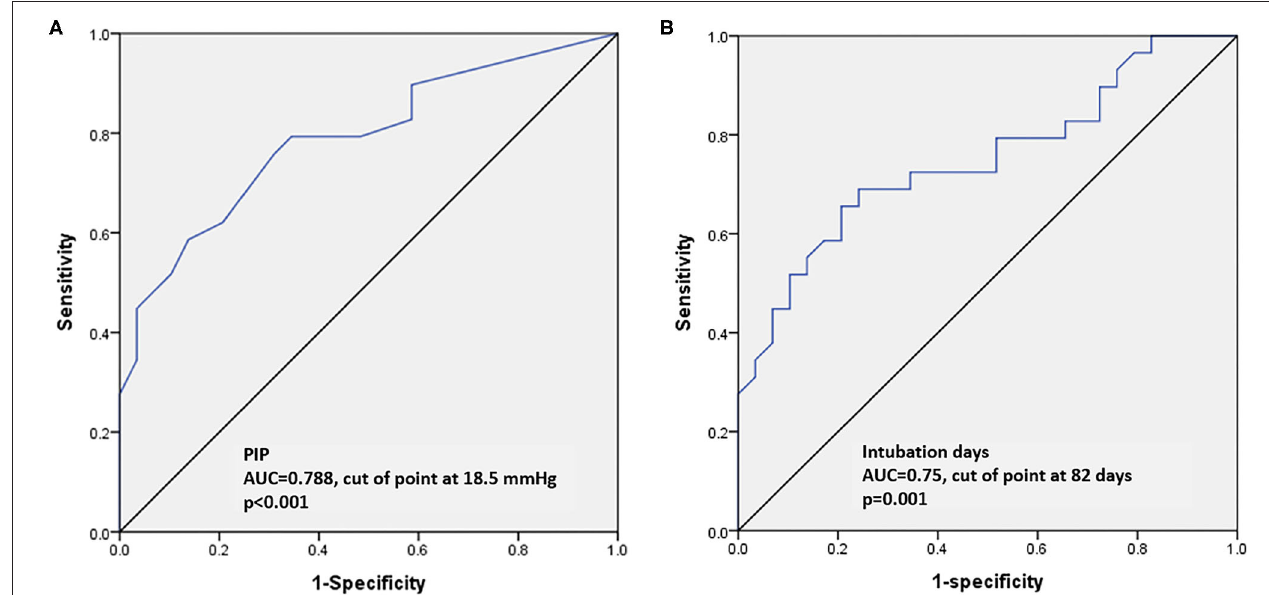
FIGURE 2 | Receiver operating characteristic curves to assess the predictive accuracy of parameters for TBM. (A) Peak inspiratory pressure. (B) Duration of intubation (days).